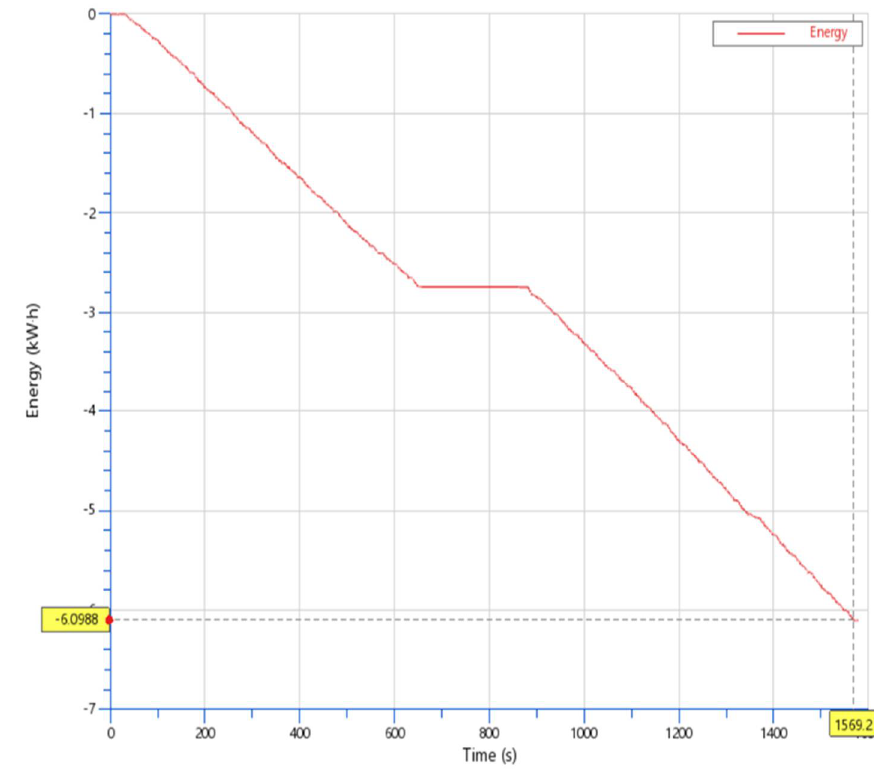
Figure 5. Energy consumption for an endurance run with the driver change in the middle.